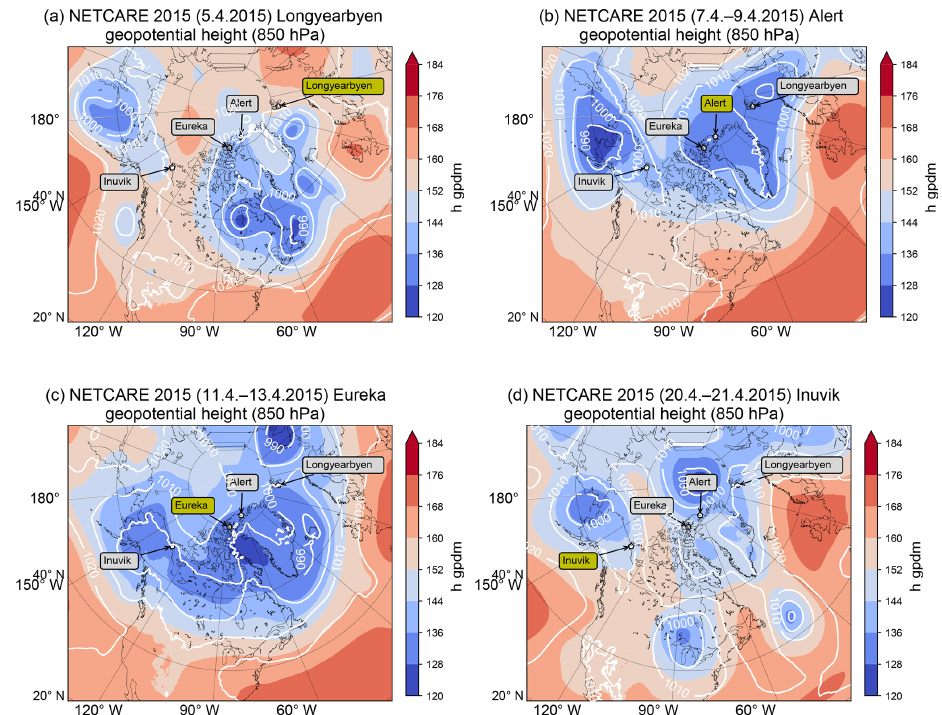
Figure 3. Mean geopotential height at 850hPa in geopotential decameters (gpdm) from 5 April 2015 (a) , from 7 to 9 April 2015 (b) , from 11 to 13 April 2015 (c) , and from 20 to 21 April 2015 (d) . Our flight location for each time period is marked in